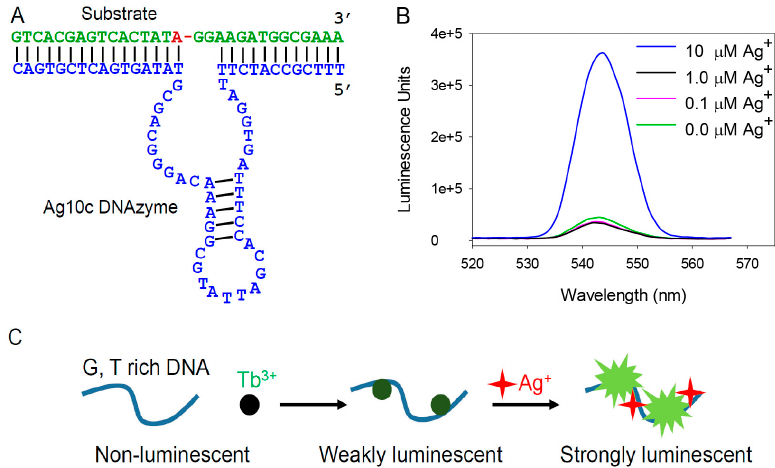
Figure 1. ( A ) The secondary structure of the Ag10c DNAzyme. For the Tb 3+ luminescence experiment, the substrate is the all-DNA analog and cannot be cleaved; ( B ) Tb 3+ luminescence spectroscopy with the Ag10c DNAzyme in the presence of 0, 0.1, 1 and 10 µM concentrations of Ag + ; ( C ) A scheme showing the effect of Ag + in promoting the luminescence of poly G, T DNA.